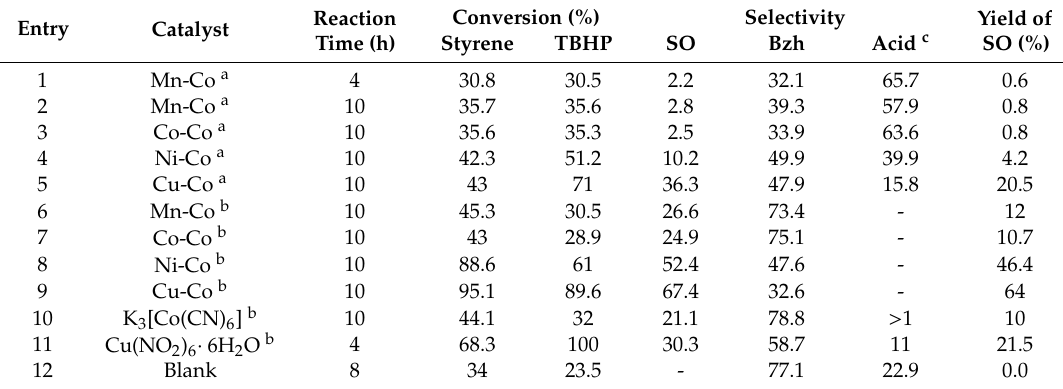
Table 3. Performance of hexacyanocobaltates complexes M 3 [Co III (CN) 6 ] 2 on styrene by tert Butyl Hydroperoxide